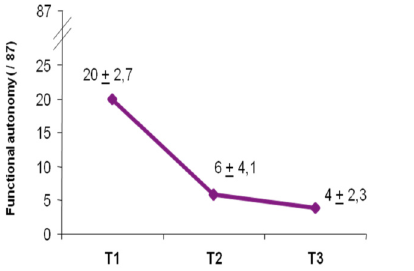
Figure 7. Functional Autonomy Measurement System (SMAF)